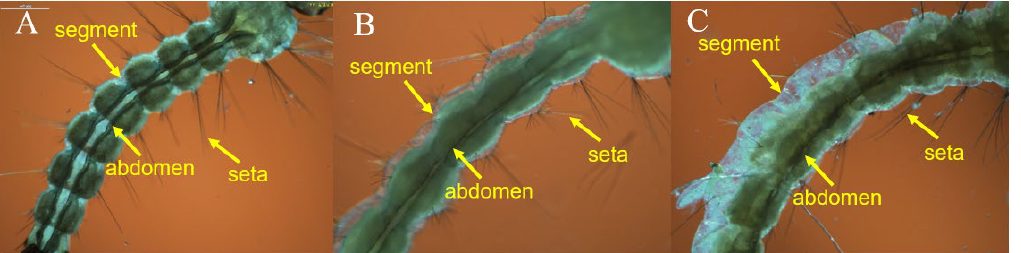
Figure 6. Observation of the larval intestinal cavity: ( A ) the negative control group; ( B ) the SOP-2q treated group; ( C ) the SOP-2r treated group.